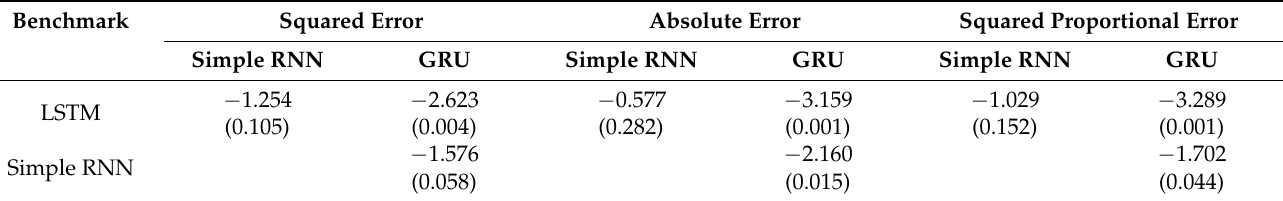
Table 4. Diebold–Mariano test